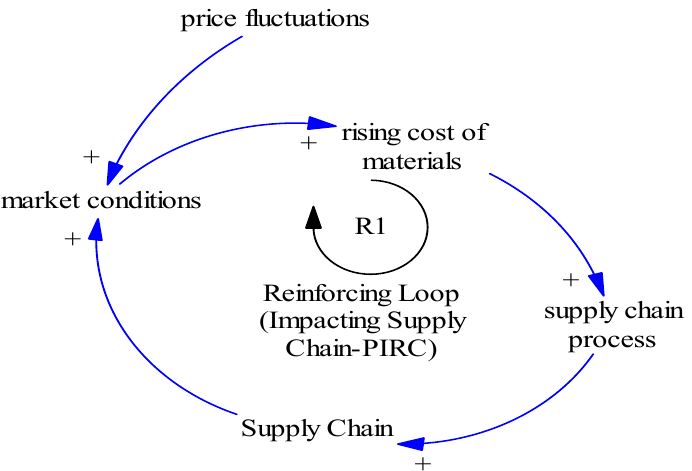
Figure 3. Impact on profitability risk category–supply chain (reinforcing loop-R1).